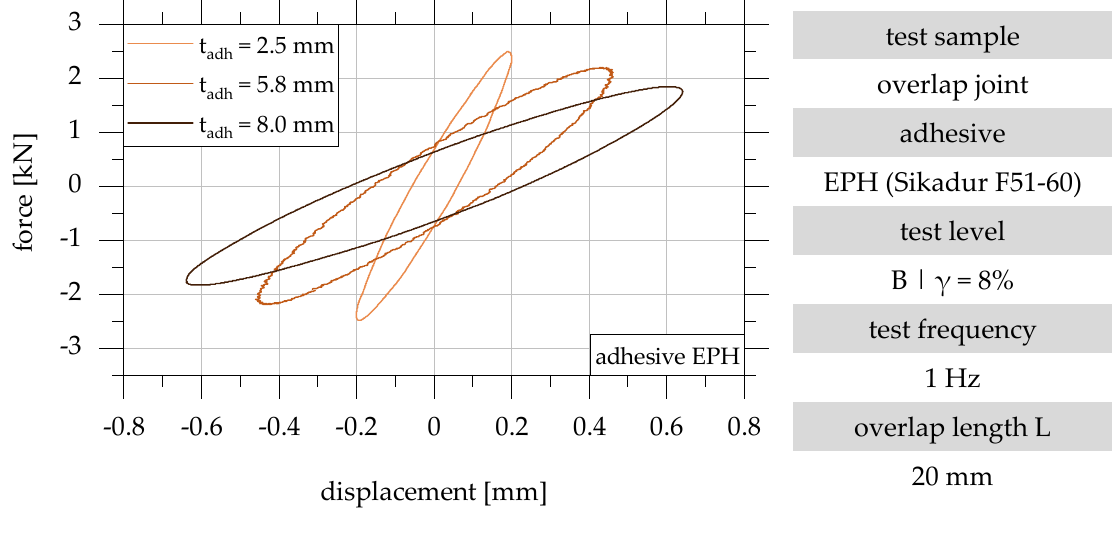
Figure 6. Force–displacement–hysteresis of the overlap joint configurations 1, 2 and 3 with an overlap length of 20 mm in test level B ( γ = 8%) in accordance with [22]. The results of the dynamic investigation of the overlap joint configurations 1, 2 and 3 in test level A are shown graphically in Figure 7 in the form of loss factors. The loss factors determined according to Section 2.2.5 are between 0.16 and 0.28. The lowest loss factor is achieved for configuration 1 and is independent of the overlap length. The maximum loss factor in test level A is 0.28 and results for configurations 2 and 3 with an overlap length of 20 mm.